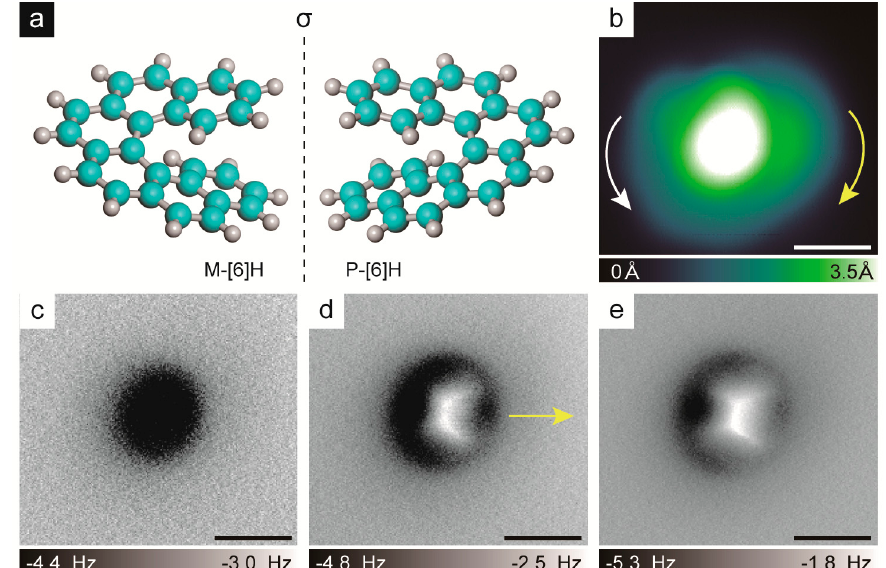
Figure 1. ( a ) Ball-and-stick models of left-handed hexahelicene ( M -[6]H) and right-handed ( P -[6]H), (cyan: carbon; grey: hydrogen). ( b ) Scanning tunneling microscopy (STM) image of P -[6]H adsorbed on Au(111) (V = 300 mV, I = 10 pA). ( c – e ) Noncontact atomic force microscopy (nc-AFM) images of P -[6]H monomer measured at different tip-sample distances of − 3 Å ( c ), − 2.4 Å ( d ) and − 2.1 Å ( e ). Scale bars: 5 Å.